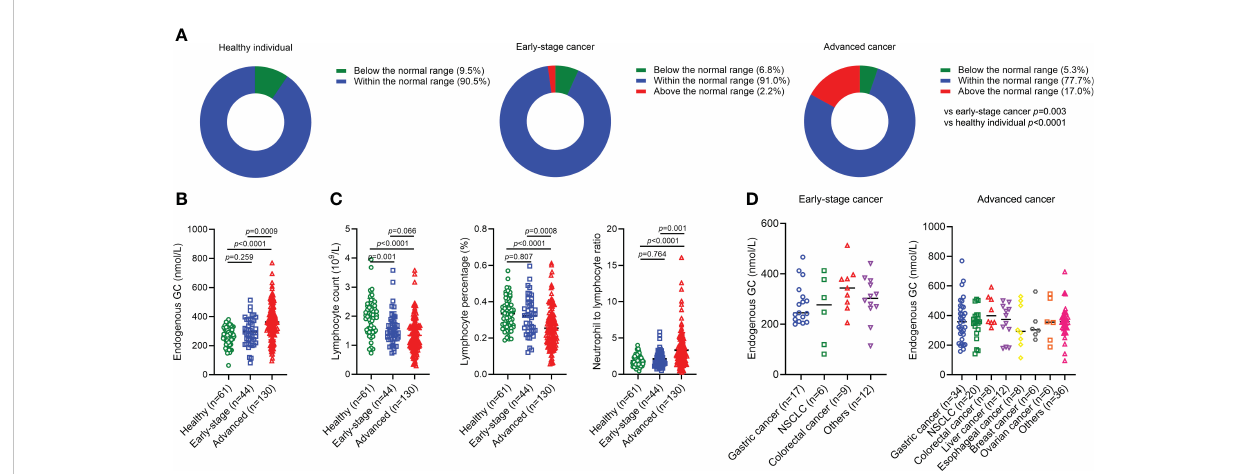
FIGURE 1 The endogenous GC levels in healthy individuals and cancer patients. (A) Comparing the percentage of endogenous GC levels above the normal range in healthy individuals (n=61) and cancer patients with early (n=44) and advanced (n=130) stages. (B) Comparing the endogenous GC levels in healthy individuals and cancer patients with different disease stage. (C) Comparing the absolute lymphocyte count, lymphocyte percentage, and neutrophil-to-lymphocyte ratio in healthy individuals and cancer patients with different disease stage. (D) The endogenous GC levels in early-stage and advanced patients with different caner types. GC, glucocorticoid; NSCLC, non-small cell lung